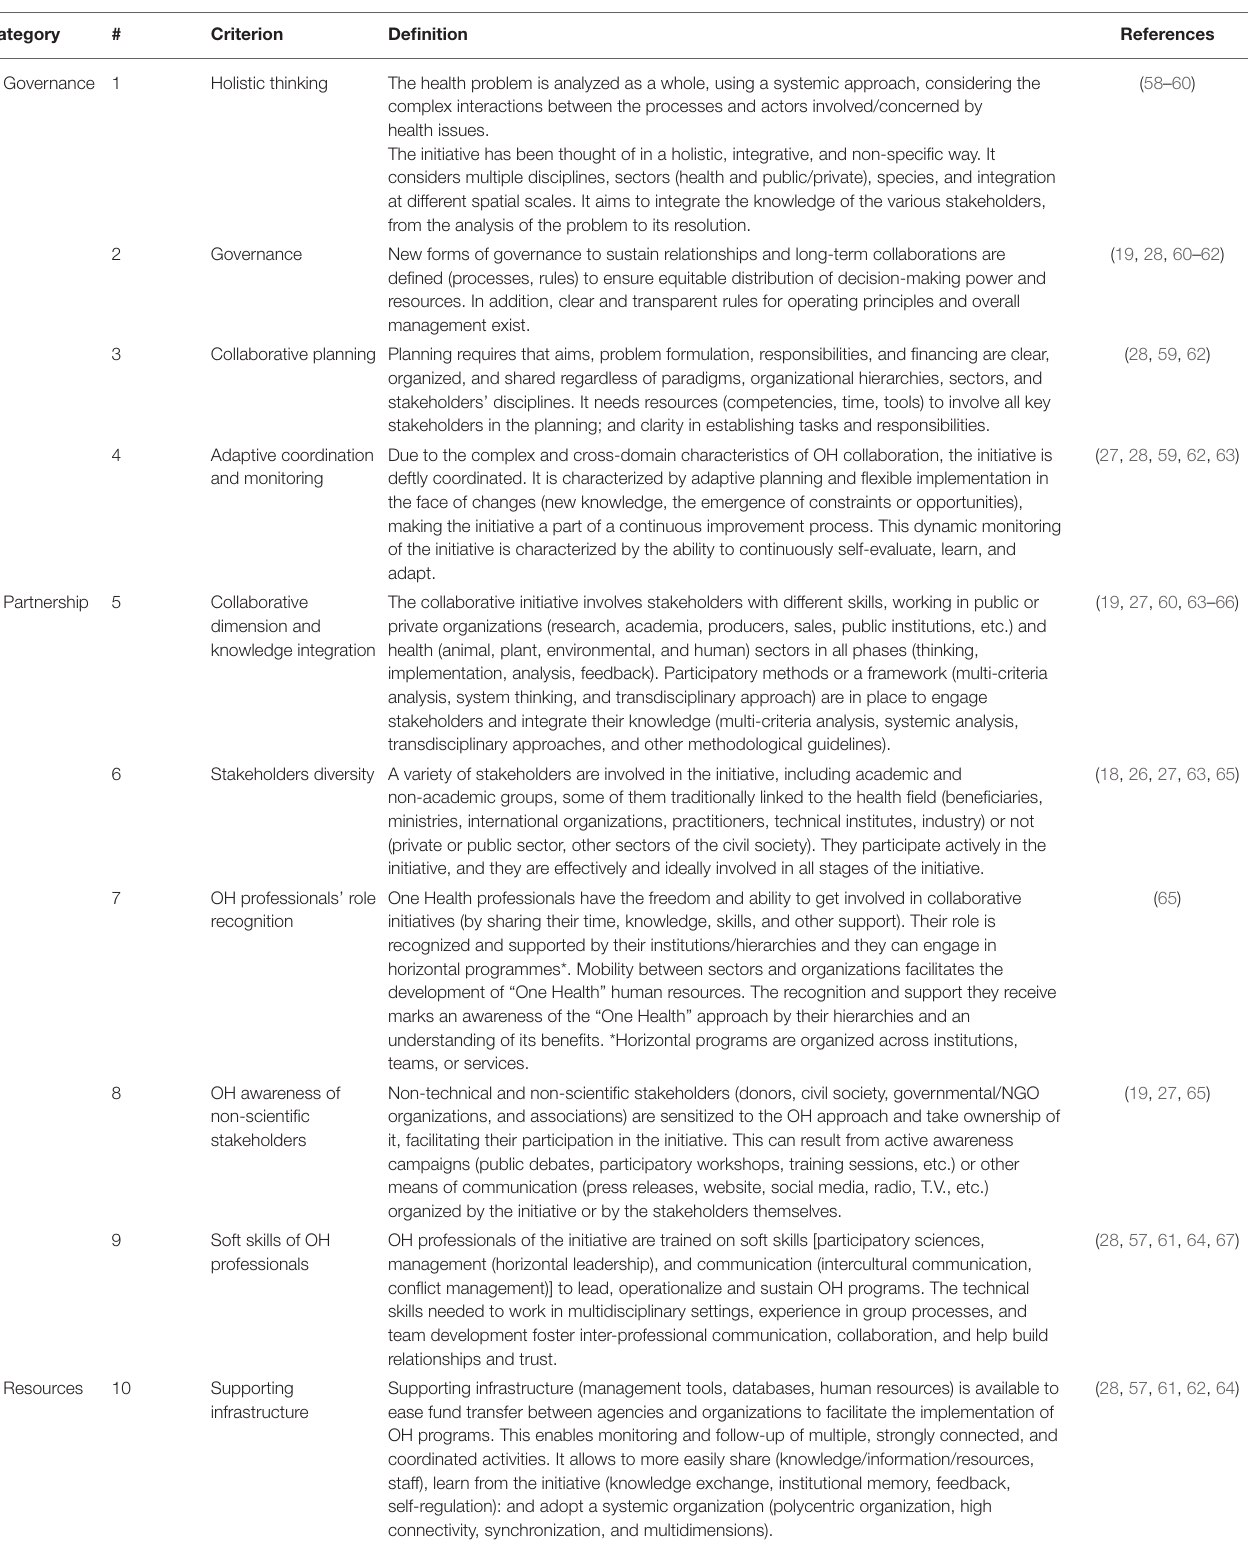
TABLE 2 | Selected criteria considered key attributes for the successful implementation of OH initiatives (ECOHI), definitions, and associated scoring.